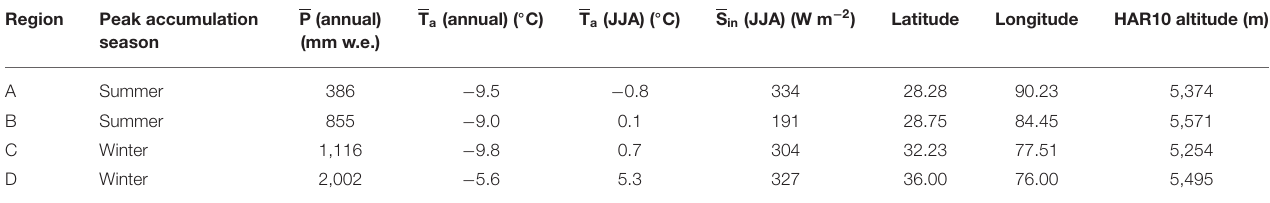
TABLE 1 | Summary of climate conditions for each region.